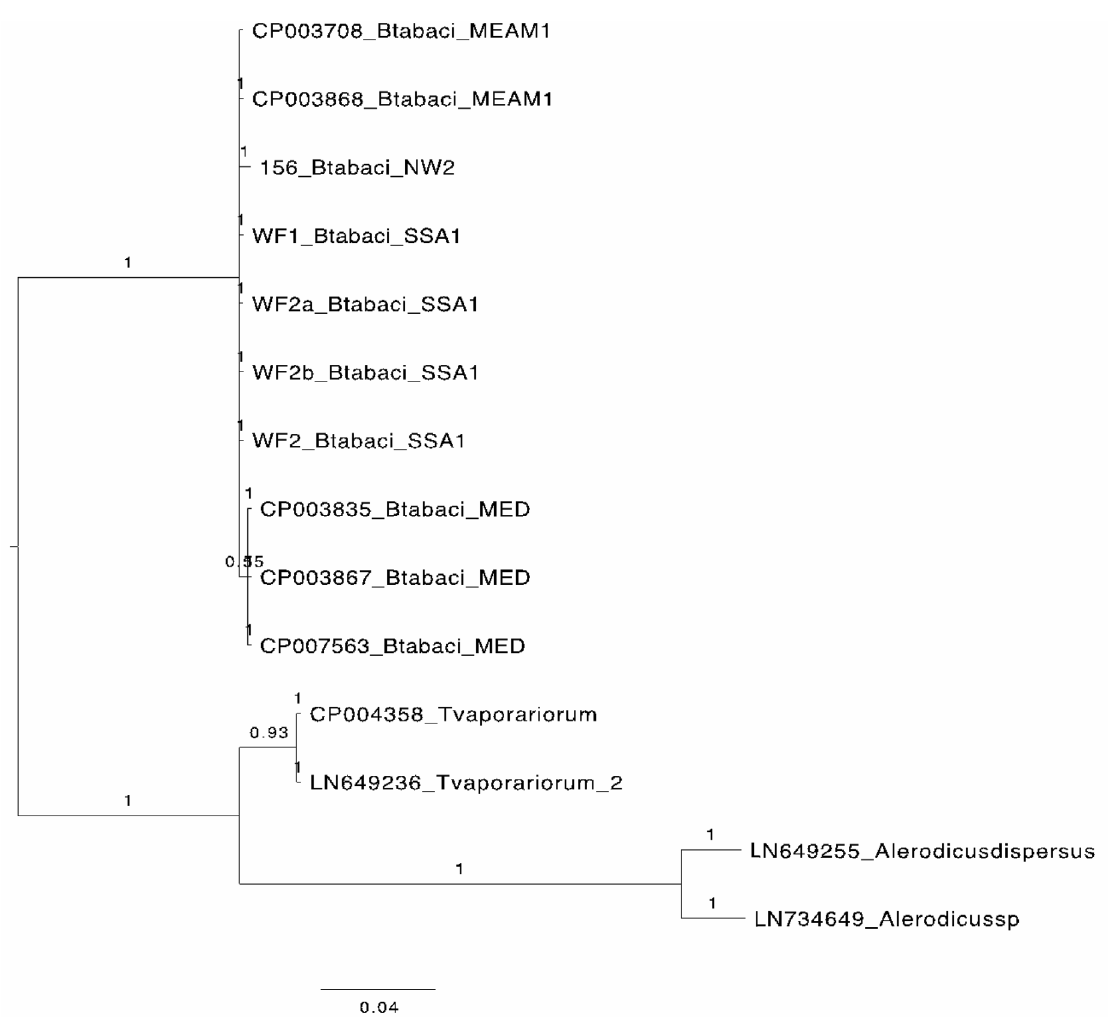
Figure 2. Bayesian phylogenetic tree of Nus G gene of P. aleyrodidarum across whitefly species using MrBayes